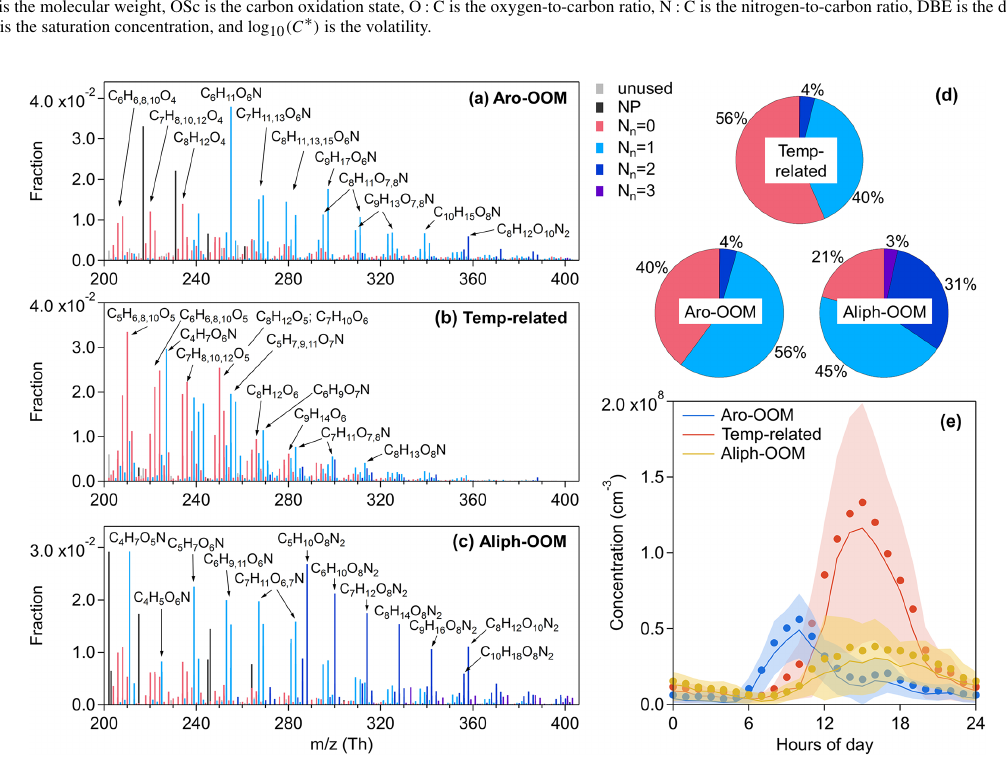
Figure 3. Mass spectra of (a) the Aro-OOM factor, (b) the Temp-related factor, and (c) the Aliph-OOM factor, and the elemental formulas of major peaks are labeled above them. Peaks are color-coded by n N as indicated at the top right of the figure, and the fractions of peaks grouped by n N are reported in (d) the pie charts. The gray bars are fluorinated contaminations or non-identified compounds. The nitrated phenols are drawn separately with black peaks in (a) – (c) and were not included in (d) . So n N can more reliably represent the number of nitrate groups in each molecule. Diurnal patterns (Beijing time) of these three factors are shown in (e) : the bold solid lines are the median values; shaded areas represent percentiles of 75% and 25%; and solid circles represent mean